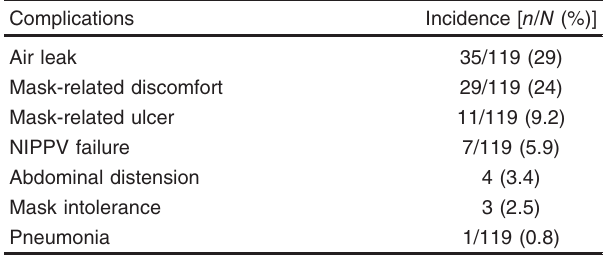
Table 9 Complications of NIMV in the studied group Complications Incidence [ n / N